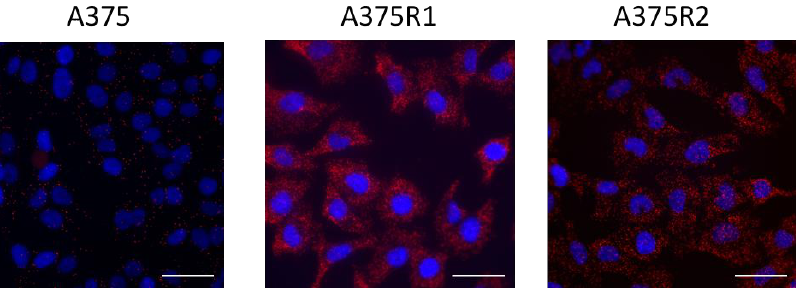
Figure 6. RAS interacts with RICTOR to promote resistance. ( A ) Cells were treated with DMSO, 1 μM of vemurafenib (V1), 3 μM (JR3) or 10 μM (JR10) of JR -AB2-011, or a combination of vemurafenib and JR-AB2-011, and the proliferation was analyzed after 3 days (data are represented as mean +/ − SD). Significance was calculated using the Student’s t -test and showed that JR10 significantly inhibited proliferation of all 3 cell lines even when combined with V1 ( p < 0.05). ( B ) A375 melanoma cell line and A375 Vemurafenib-resistant cell lines (A375-R1 and A375-R2) were treated for 24 h with DMSO, Vemurafenib (1 μM), 3 μM (JR3) or 10 μM (JR10) of JR -AB2-011, or a combination of vemurafenib and JR-AB2-011, and the expressions of phosphorylated STAT3 (pSTAT3) and total STAT3 were assessed by Western blotting. ( C ) RAS interactions with RICTOR in A375 parental and resistant cell lines cells detected by in situ PLA. The interactions were visualized as fluorescent red dots. DAPI- stained nuclei (blue). Scale bar, 50 μm.